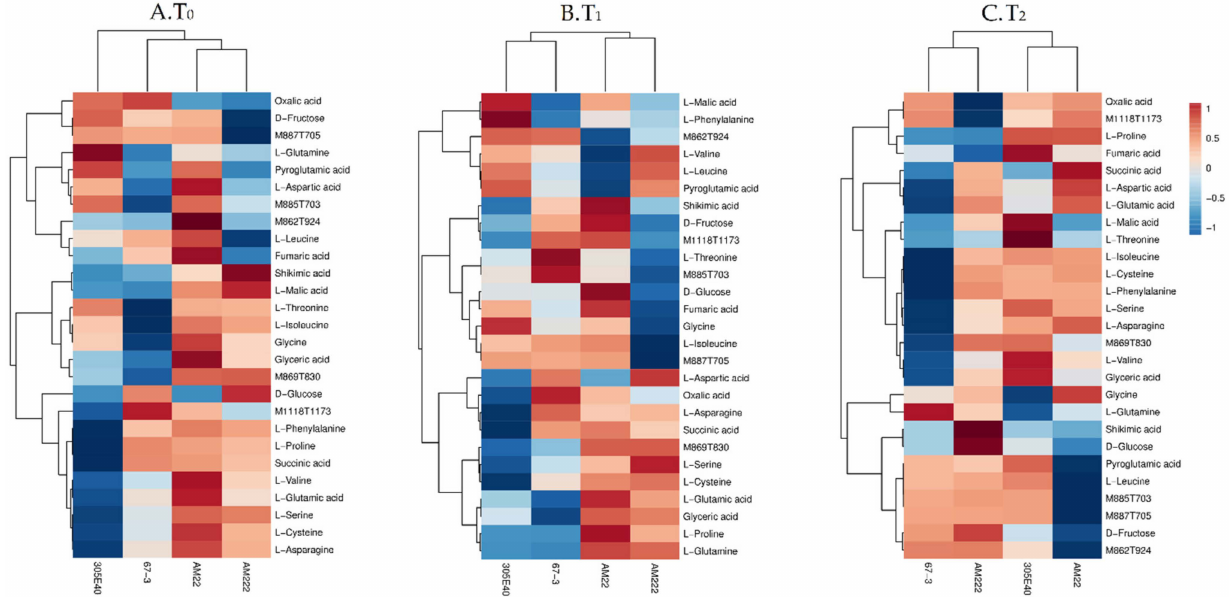
Figure 4. Heatmap of metabolites significantly differentially abundant among genotypes in shoot (one-way ANOVA and post hoc with p ≤ 0.05). Each column and row represent a sample and a metabolite, respectively. Comparison among genotypes shows that the main differences are in the primary metabolites at T 0 ( A ), T 1 ( B ), and T 2 ( C